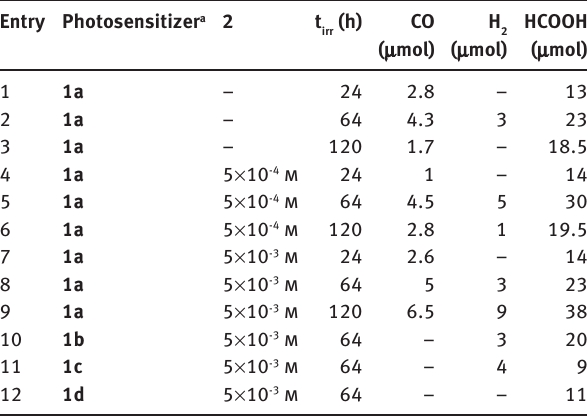
Table 2 Photocatalytic reduction of carbon dioxide. a